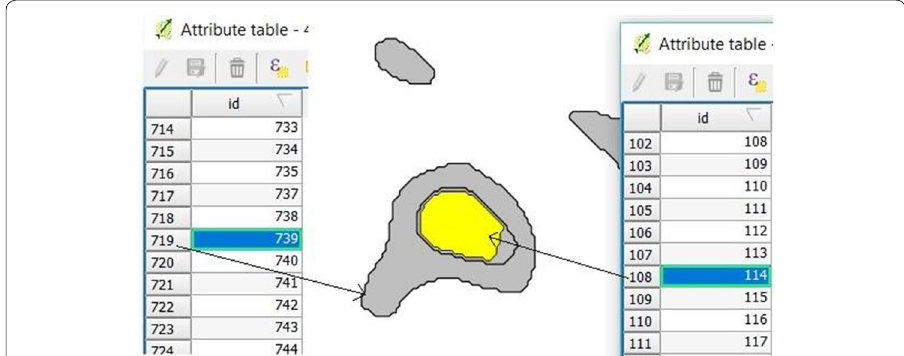
Fig. 19 Topological relationship for Case